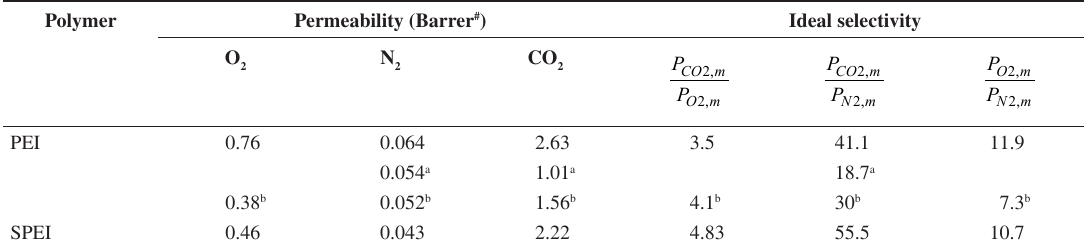
ideal selectivity at (24.7 ± 1.5)°C and 3 bar through the membrane. 2